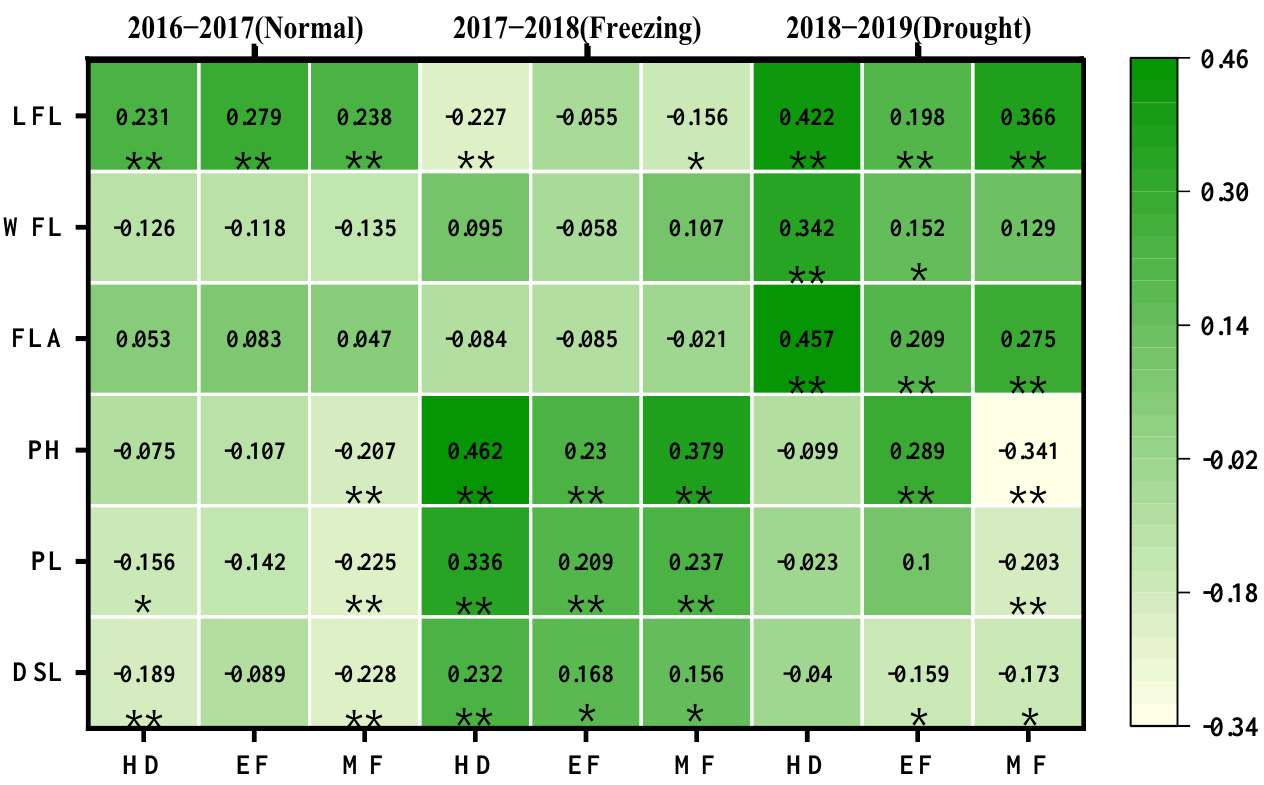
from the spike to the leaf ( − 0.228).